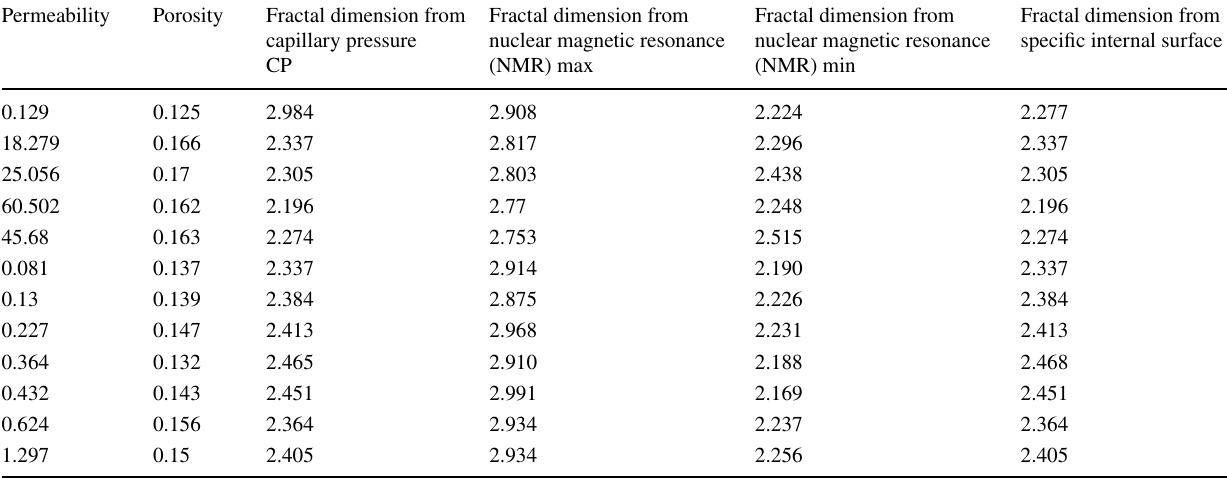
Table 6 Data from literature source (Zhang and Weller 2014) Permeability